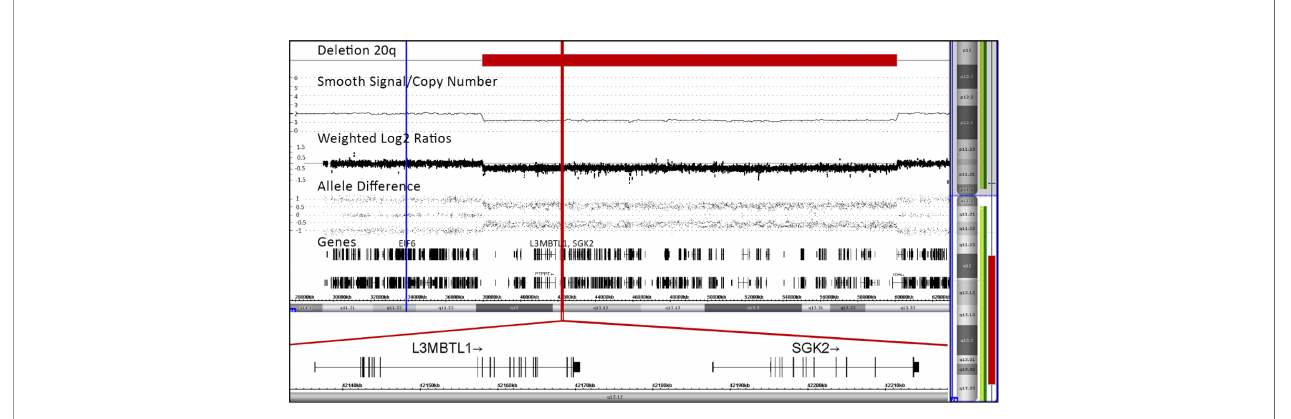
FIGURE 2 | Array pattern of long arm of chromosome 20 showing the interstitial deletion with the following bordering coordinates: chr20:37948298-60071887 (hg19). The deletion extends over 22,124 Mb and encompasses 244 genes, a list of which is provided in the Supplementary Table 2 . The location of the three potentially most relevant genes, EIF6, L3MBTL1 and SGK2 , are indicated with blue and red lines, respectively (24 – 28). The orientation and detailed structure of the two imprinted ones in the deletion are shown in the blown-up section on the bottom part of the